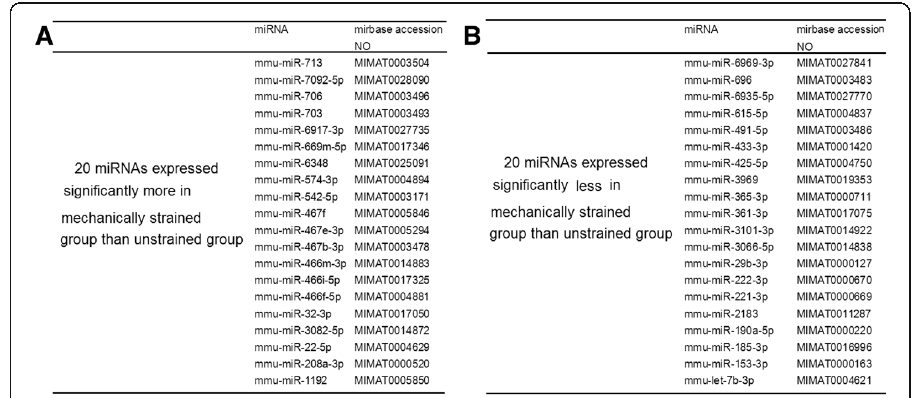
Fig. 2 A total of forty differentially expressed miRNAs were selected by microarrays. a : up-regulated miRs, b : down-regulated